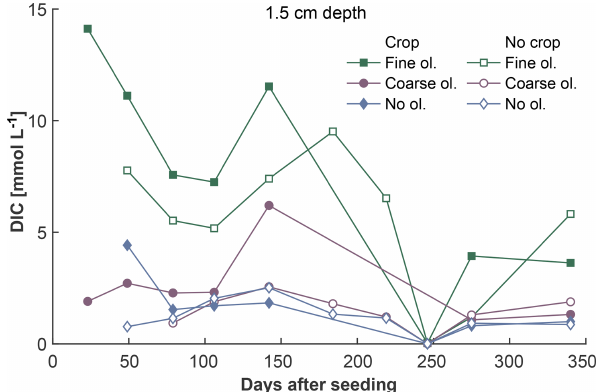
Figure 4. Development of pH values (averaged proton concentra- tions, converted to pH) over the experiment period at 1.5cm depth, differentiated by olivine and crop treatment. For more data and error bars, please refer to Fig.